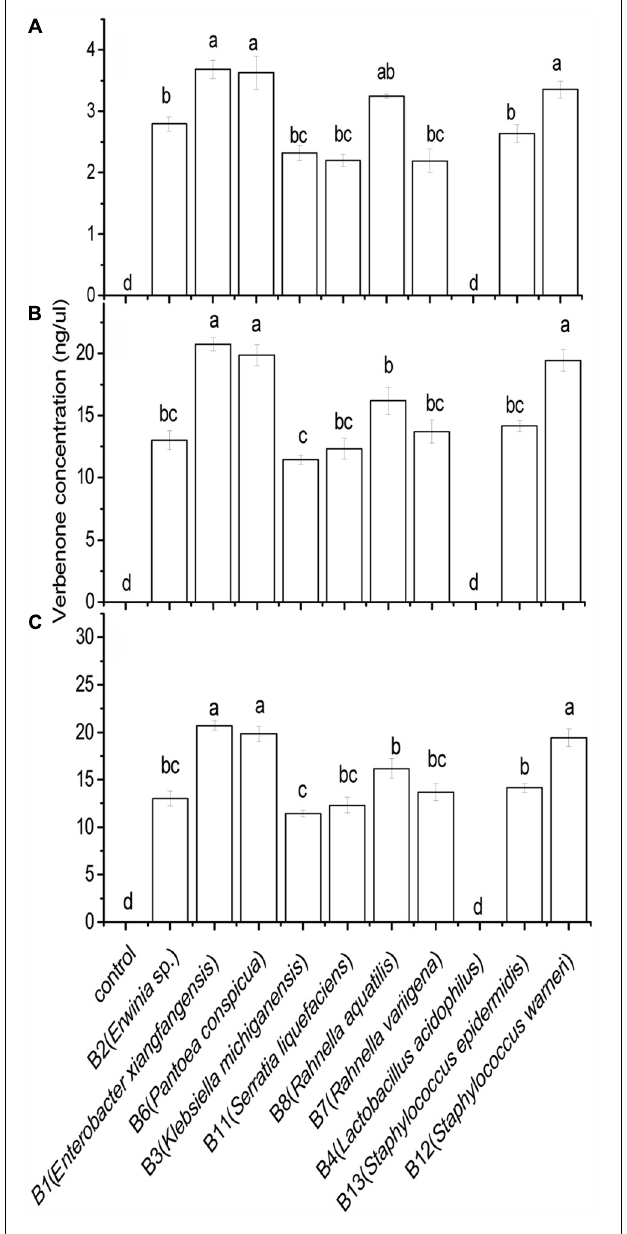
FIGURE 3 | Verbenone production by Dendroctonus valens gut associated facultative bacteria under anaerobic environment. The amounts of verbenone produced by facultative bacteria at (A) 4 ng/ µ l, (B) 40 ng/ µ l, and (C) 200 ng/ µ l cis -verbenol concentrations. Statistical analysis was performed using Dunnett’s T 3 test. The bars with different letters are significantly different at P =